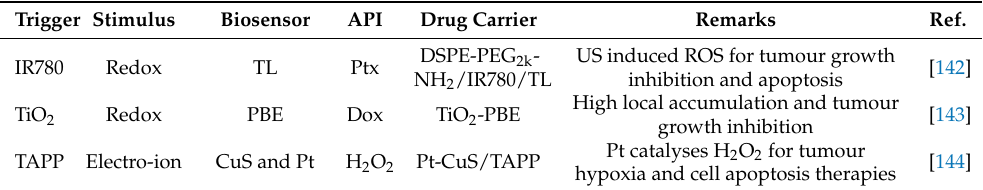
Table 7. Sonodynamical triggers with biosensors with added redox and electro-ion stimuli in drug carriers, with remarks listed.